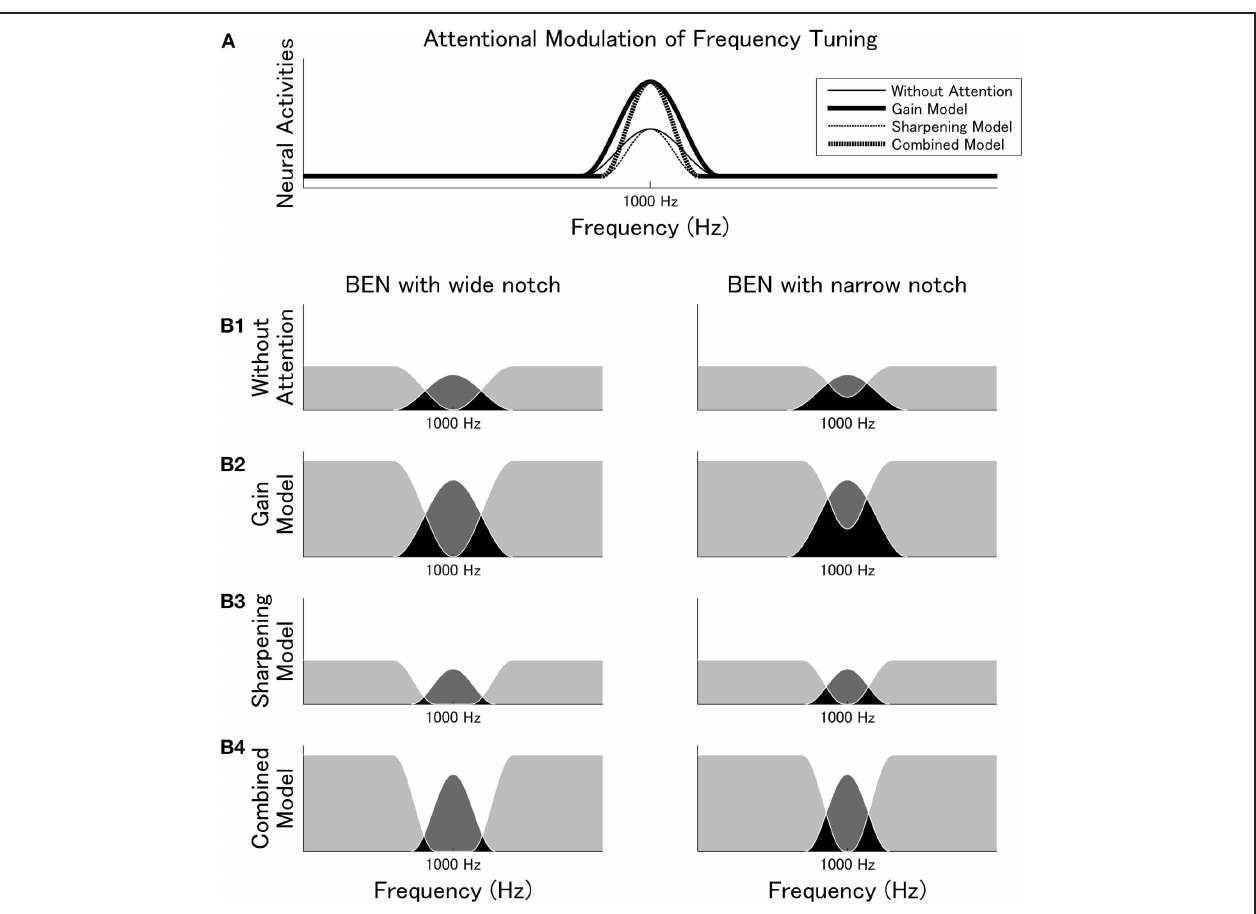
FIGURE 6 | ( Modified from Okamoto et al., 2007a,b ) Attentional modulation of frequency tuning. (A) Different effects of attention (gain, sharpening, and combined (gain plus sharpening) models) modulate the population-level neural activities corresponding to the 1000Hz test stimulus. (B1–B4) The relationship between neural activities elicited by BEN and TS as predicted by the different attention models. Light gray areas represent neural activities exclusively elicited by BEN and dark gray areas represent neural activities exclusively elicited by TS. Black areas indicate overlap: neurons in these areas had already been activated by BEN when TS appeared. Dark gray